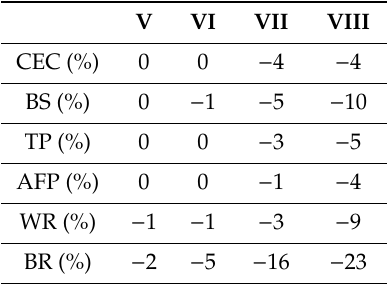
Table 5. Changes in composts characteristics following treatment with emulsion A, where: V = 1 Lt − 1 , VI = 5 Lt − 1 , VII = 10 Lt − 1 and VIII = 50 Lt − 1 spraying intensity. Results are expressed as % change in comparison to blank sample (no emulsion treatment =